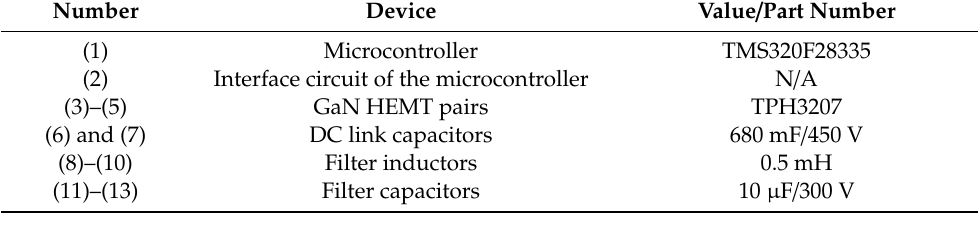
Figure 18. ( a ) Photo of GaN-based three-phase APF hardware; ( b ) schematic of the hardware test and system. Table 3. Devices in Figure 18a.